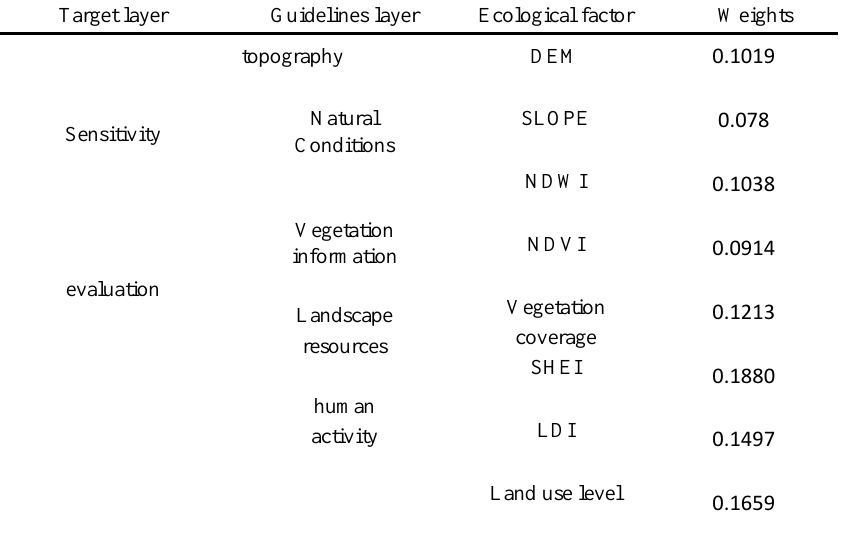
Table 4 the weight of ecological factor